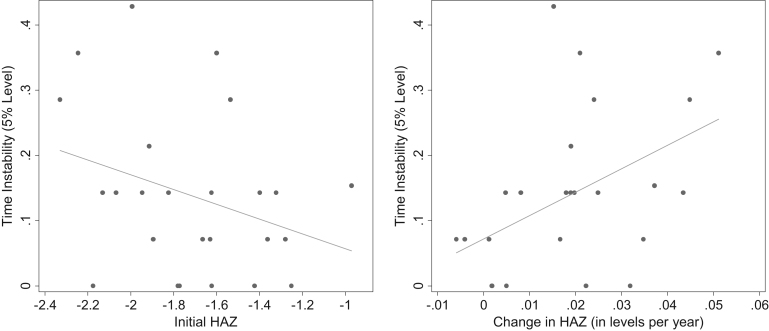
Time instability of the flexible model versus initial and change in height-for-age z-score in Demographic and Health Surveys in 25 countries. Legend: Each country represents a point in each graph. Y-axes: % covariates with significantly unstable coefficients between the first and last survey in each country (5% significance level), excluding growth faltering variables. X-axes: left, HAZ in the first survey; right, average annual change in HAZ between first and last survey. Abbreviation: HAZ, height-for-age z-score.